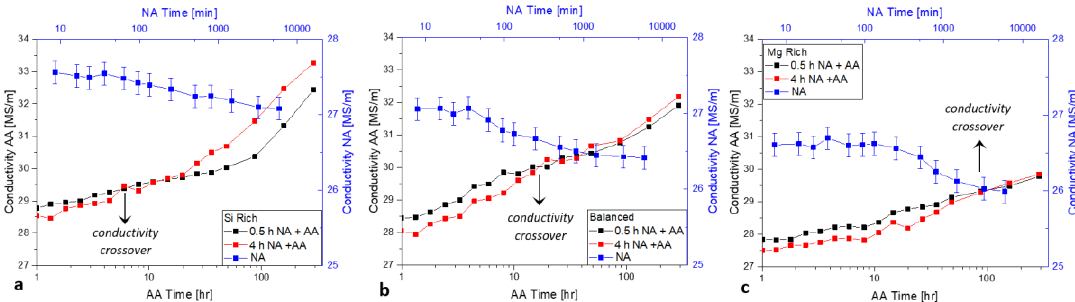
Figure 7. Conductivity evolutions during aging in the high strength Si-rich ( a ); balanced ( b ); and Mg-rich ( c ) alloys after AC from ST. The primary axes correspond to AA (175 °C with 0.5 or 4 h prior NA), and the secondary axes correspond to NA itself (~21 °C). Error bars represent 95% confidence, and the discrepancy is for the same reason as Figure 4.